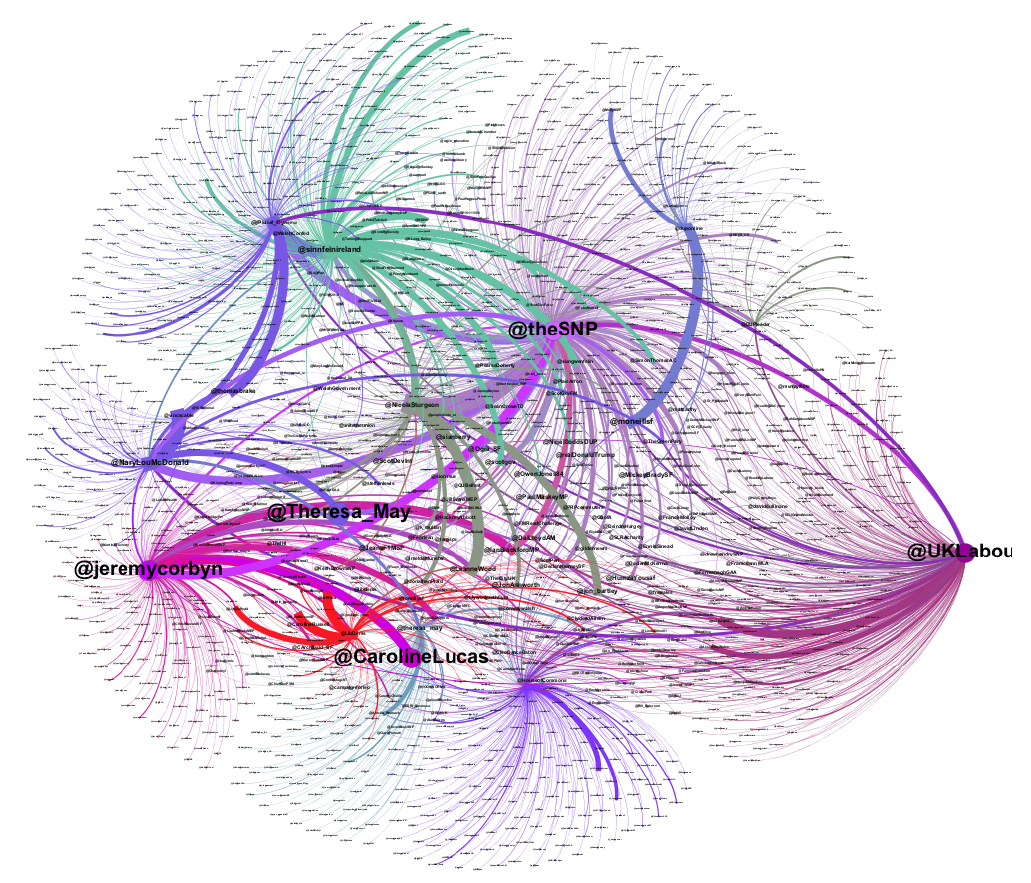
Figure 2. Twitter network, UK